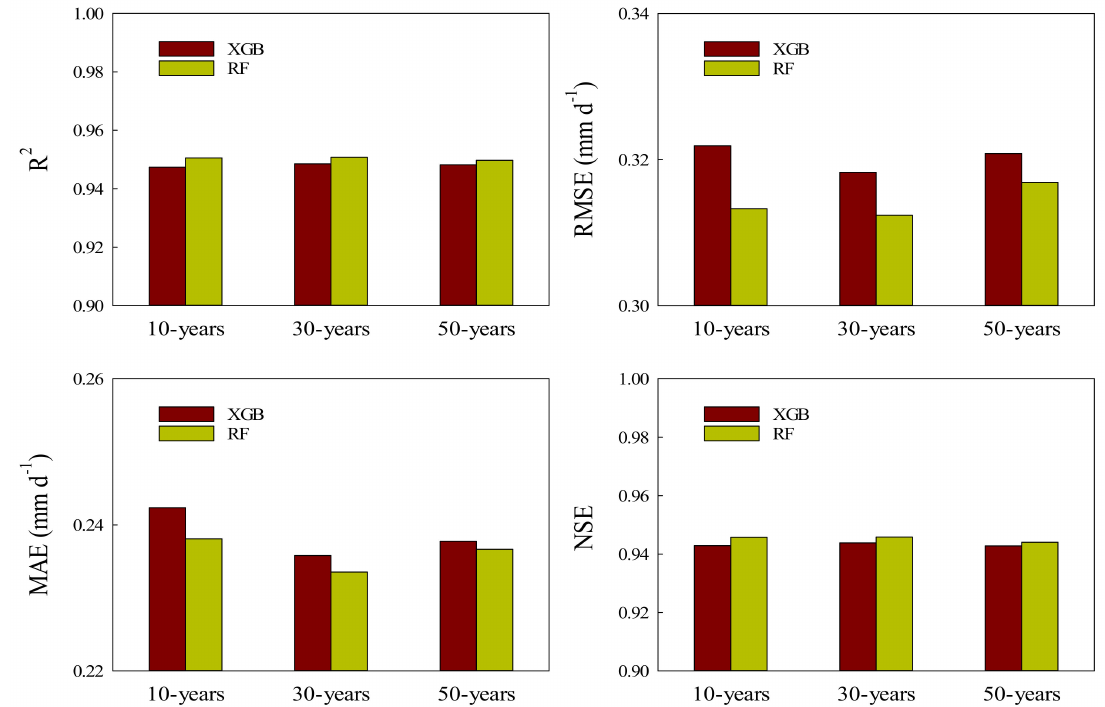
Figure 7. Bar chart of each average statistical indicator value in the fixed test dataset (2016–2019) with S5 proportion under combination 2 of random forest and extreme gradient boosting